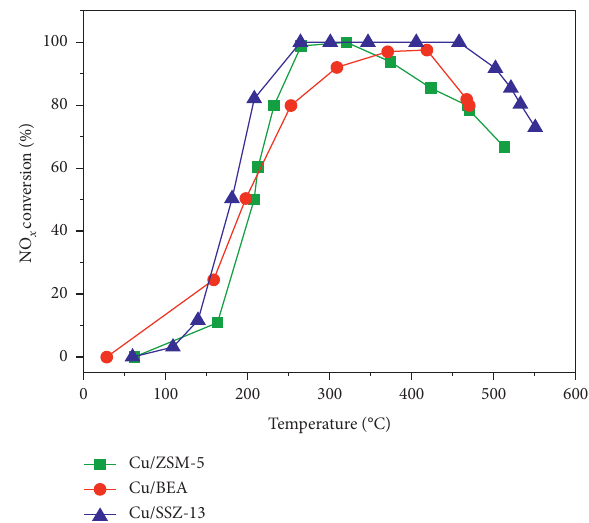
Figure 6: Comparison of SCR activity on Cu with different